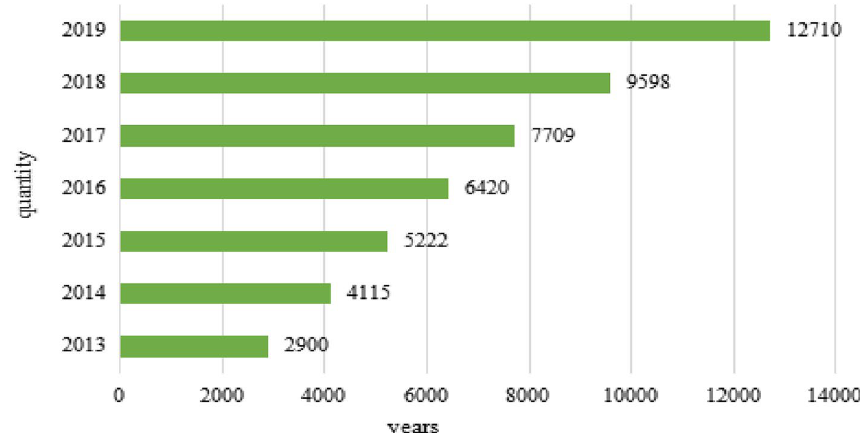
Fig. 12 Scale of China’s Internet of Things industry from 2013 to